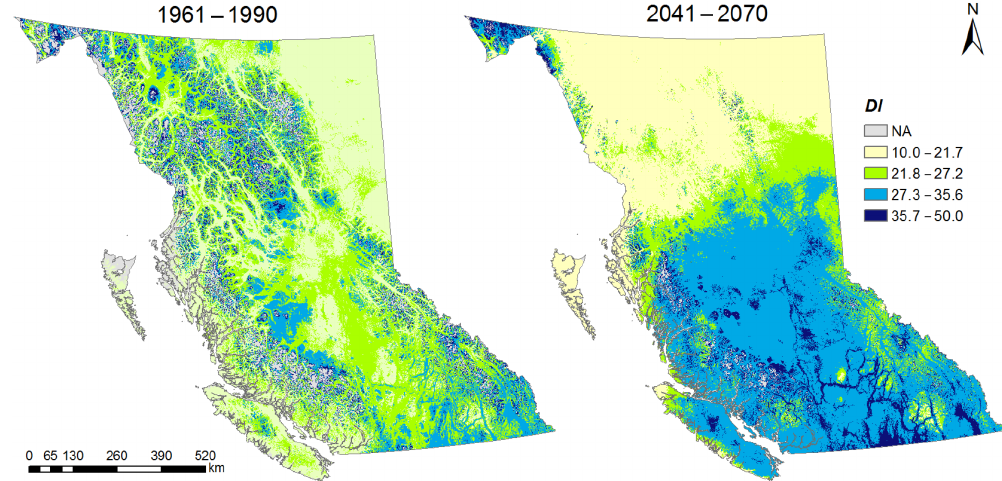
Figure 3. Map of predicted seed dormancy using climatic model for the reference period and 2050s in lodgepole pine across British Columbia. Note: DIs (i.e., dormancy indexes) are classified into five categories and represented by different colors on the map. The higher the value, the more dormant the